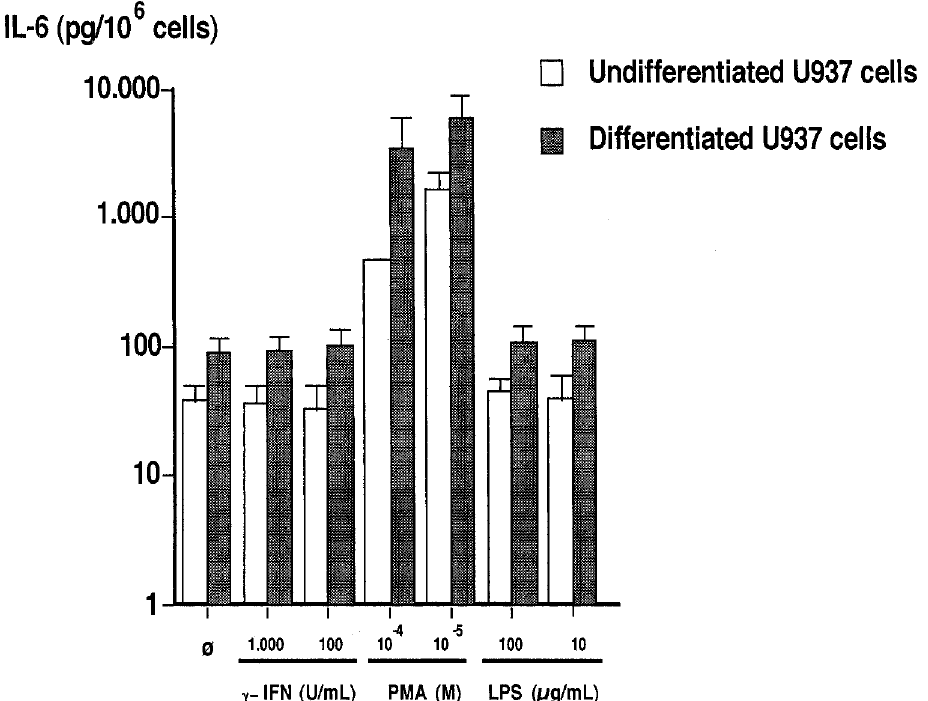
FIG. 1. Effect of different stimuli on IL-6 secretion by U937 cells. The most potent stimulus of cytokine secretion was PMA at a concentration of 10 –5 M. Definition of abbreviations: IFN, interferon; IL-6, interleukin-6; LPS, lipolysaccharide; PMA, phorbol myristate acetate. Note the logaritmic